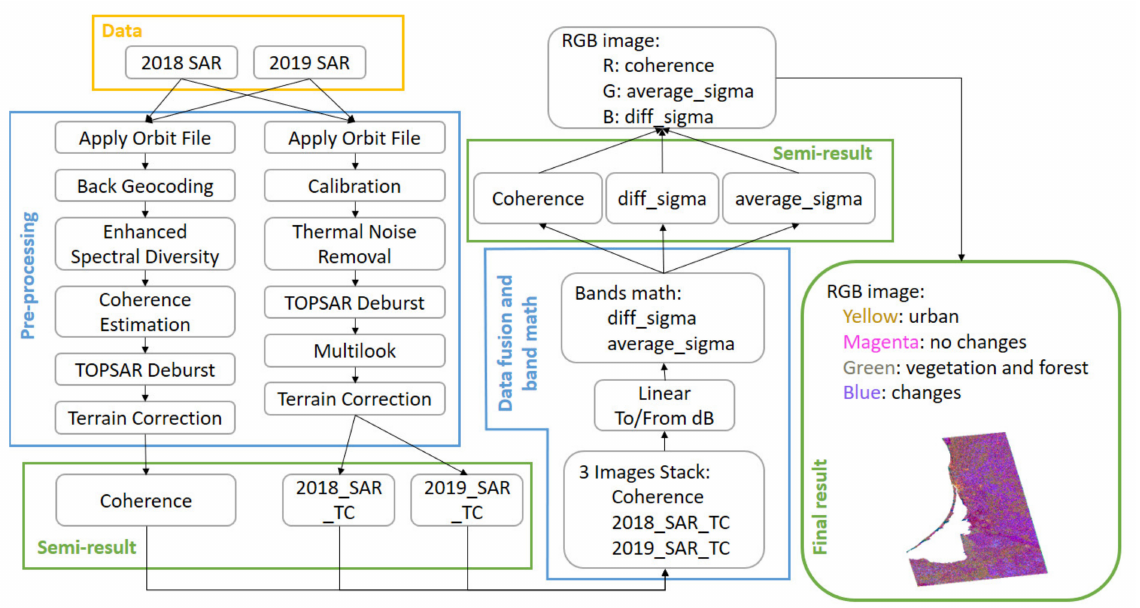
Figure 5. Processing schema of coherence